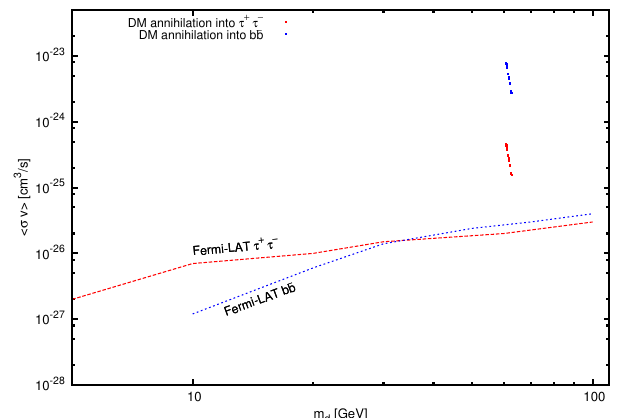
Figure 3 . The dark matter velocity-averaged annihilation cross section into b (cid:22) b (blue) and (cid:28) + (cid:28) (cid:0) (red) for the DM mass up to 100 GeV. For both channels the DM masses 61{62 GeV shown in (cid:12)gure 1 are excluded by the Fermi -LAT b (cid:22) b and (cid:28) + (cid:28) (cid:0) upper limits.